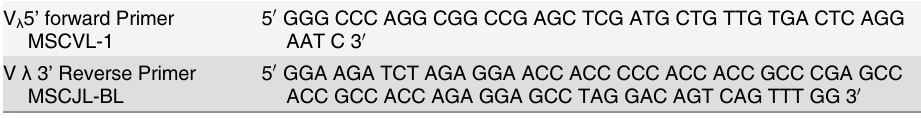
Table 4. V λ 5 ’ and 3 ’ primers for construction of a murine scFv library (pCOMB3xSS). V λ 5 ’ forward Primer